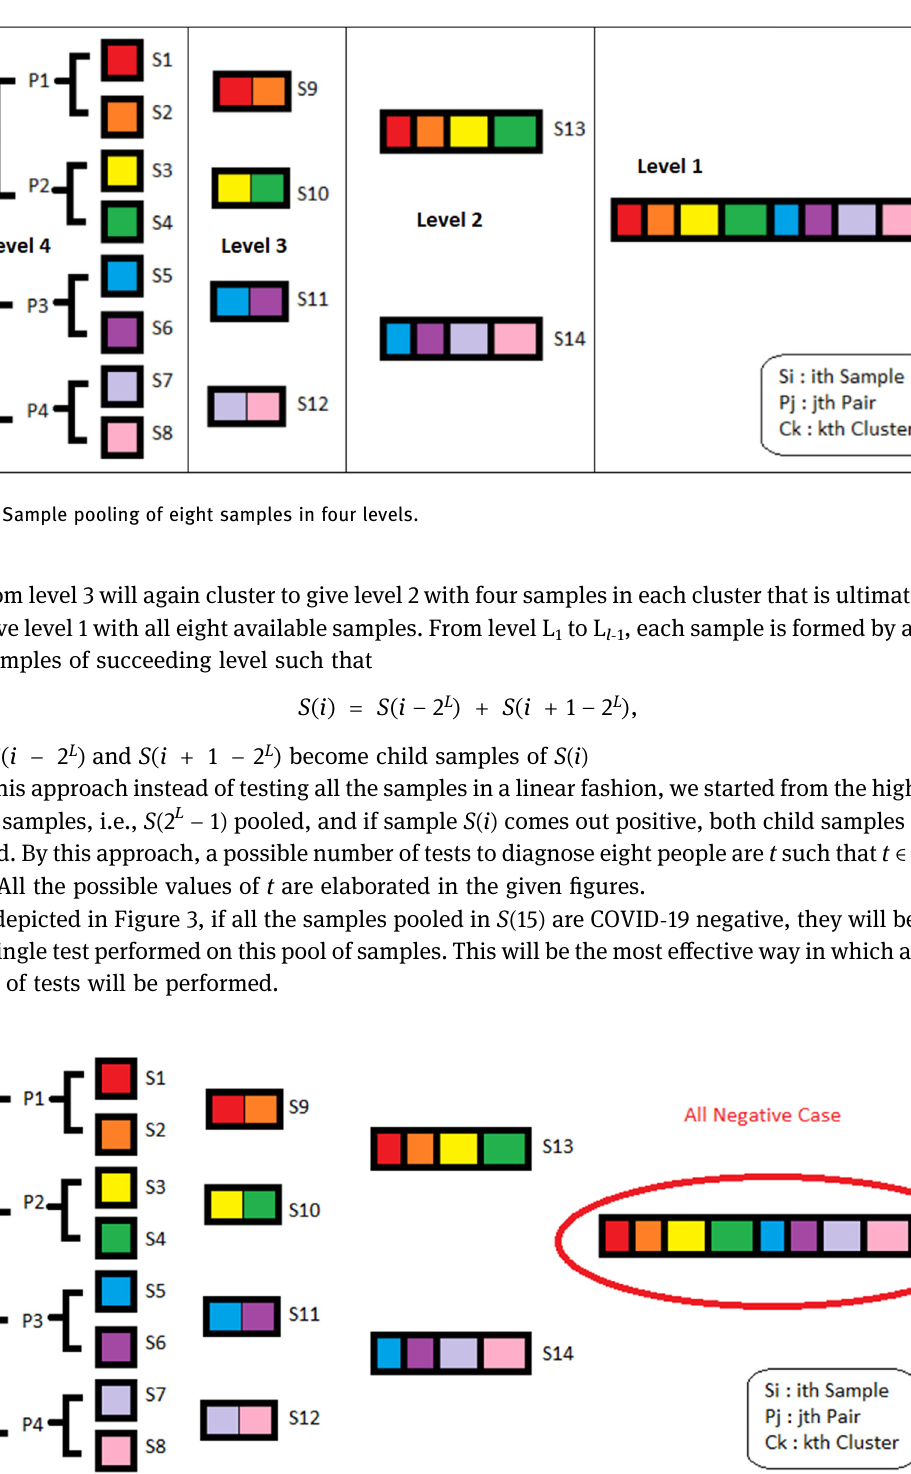
Figure 3: One test to be performed for testing eight